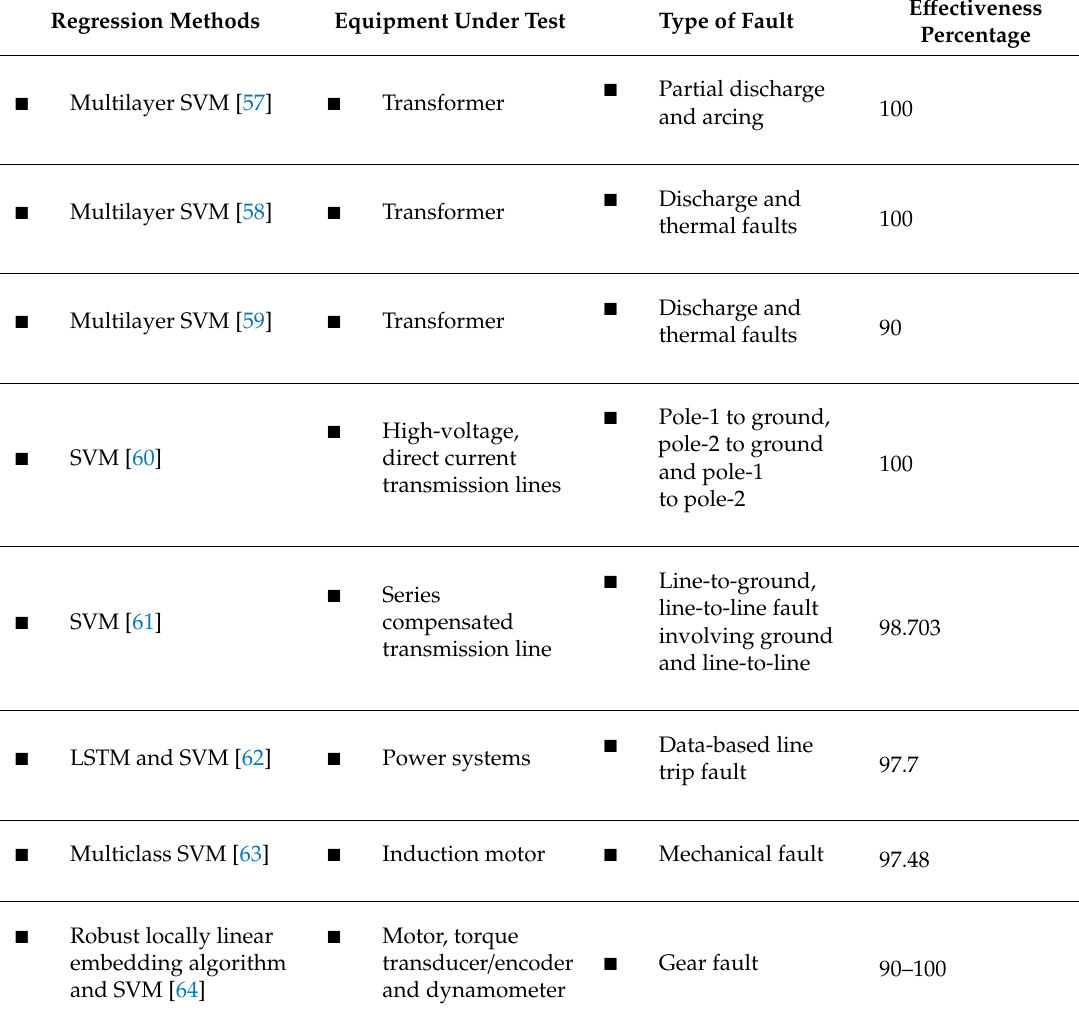
Table 2. Regression-based methods and their